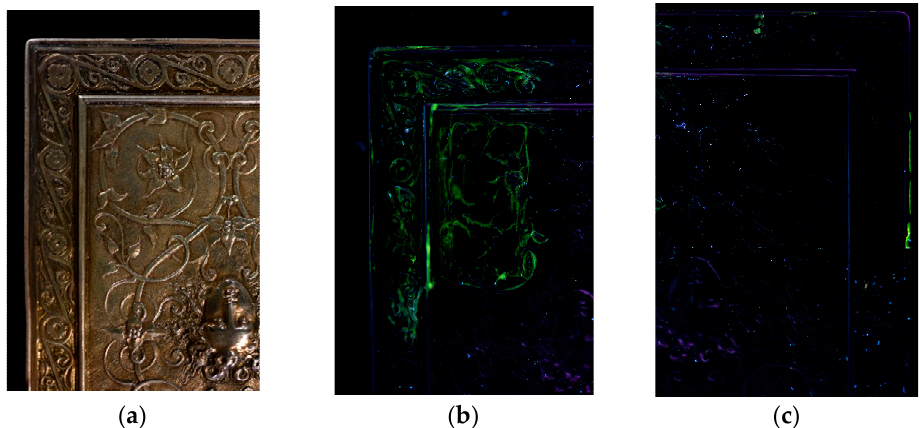
Figure 9. A historical silver object with surface relief: ( a ) under normal lighting, ( b ) under UV light after removal of a xanthan gel containing 10 − 4 M fluorescein, ( c ) under UV light after removal of an agar gel containing 10 − 4 M fluorescein (© E. Guibert-Martin/Arc’Antique—Grand Patrimoine de Loire Atlantique, Nantes, France).